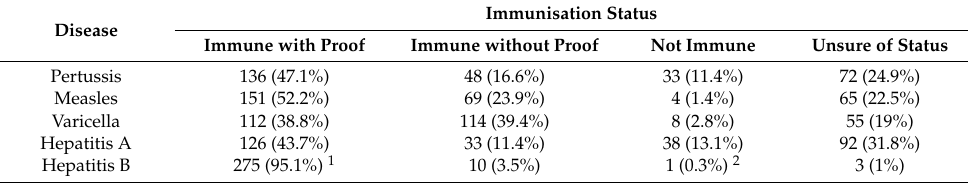
Table 3. Rates of documented immunity to selected vaccine-preventable diseases among medical students. Disease Immune with Proof